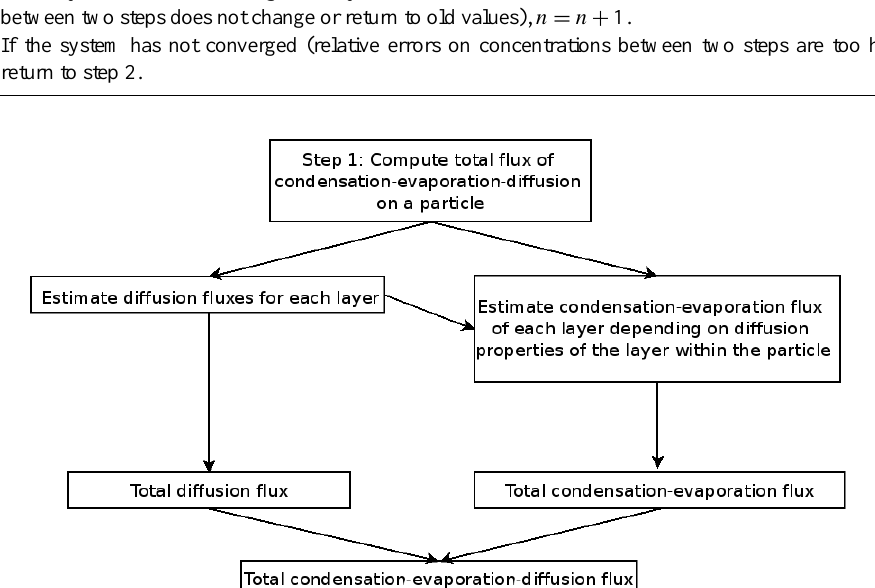
Figure 3. Diagram of the first step of the algorithm to compute evaporation–condensation–diffusion fluxes.